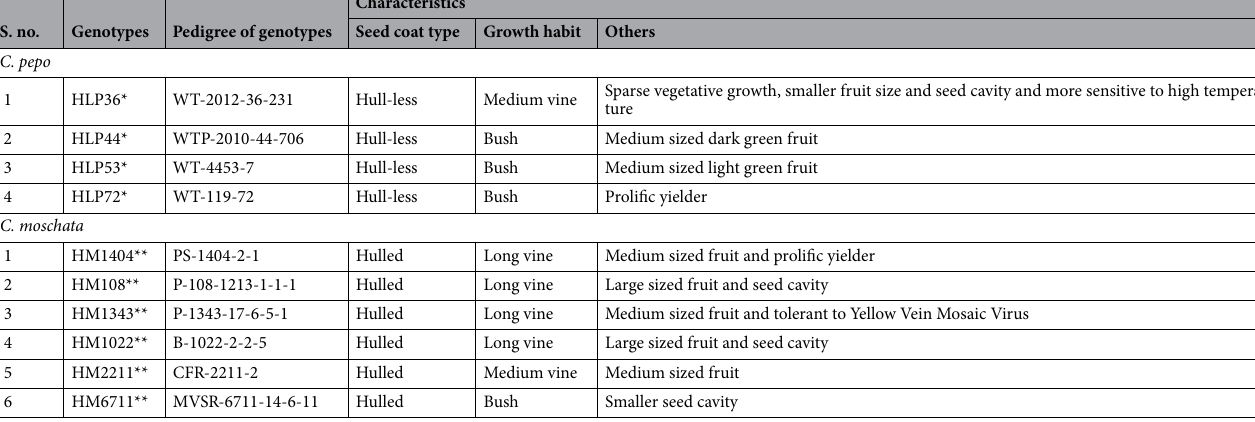
Table 7. C. pepo and C. moschata genotypes. *HLP: Hull-less C. pepo , **HM: Hulled C.